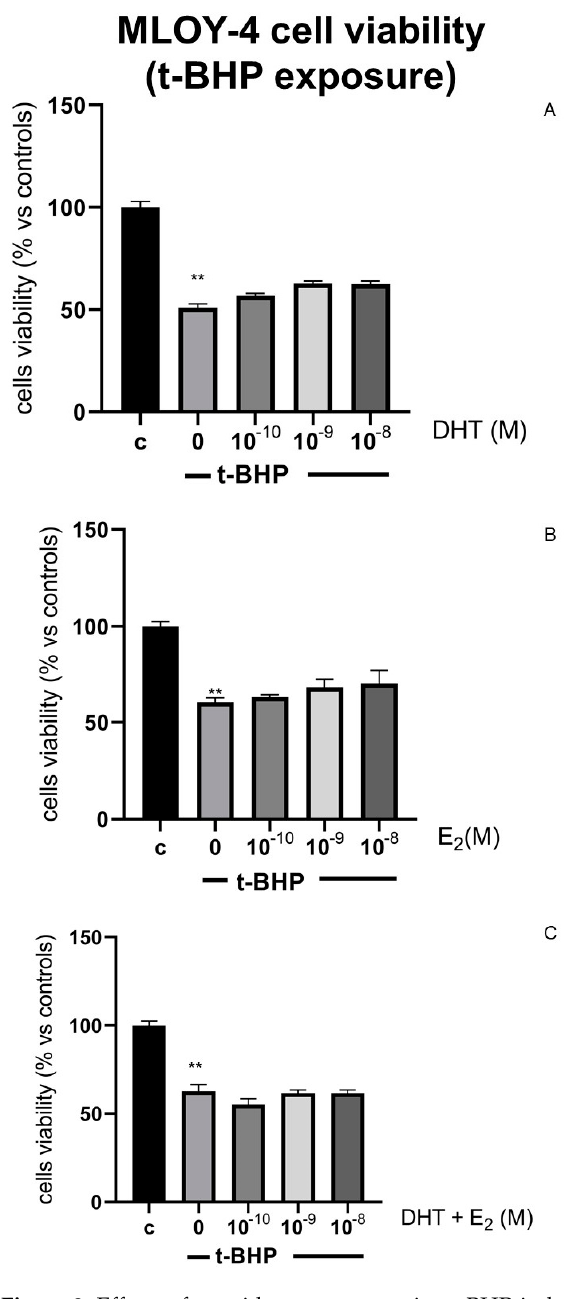
Figure 3. Effects of steroids on counteracting t-BHP-induced oxidative stress in osteocyte-like cells, MLOY-4. Effects of steroids on t-BHP-induced cytotoxicity in osteocyte-like cells, MLOY-4. Cells were pre-treated with E2 or DHT (range between 10 − 10 M to 10 − 9 M), 24 h before being treated with t-BHP (125 µ M for 3 h). Cell viability was measured by MTT assay 2 h after treatment. ( A ) shows the effects of DHT on t-BHP-induced cytotoxicity in MLOY-4 cells; ( B ) shows the effects of E2 on t-BHP-induced cytotoxicity in MLOY-4 cells; ( C ) shows the effects of a co-treatment of E2 + DHT on t-BHP-induced cytotoxicity in MLOY-4 cells. Data are represented as the mean ± SEM of six replicates within a single experiment. Column C represents the control (w/o steroids treatment and w/o t-BHP exposure); column 0 represents the t-BHP group w/o steroids. The columns 10 − 10 , 10 − 9 , 10 − 8 represent the columns with increasing doses of steroids and exposed to t-BHP. Differences between groups were evaluated by one-way ANOVA, followed by Bonferroni post-hoc test. The experiment was repeated three times. ** p < 0.05 vs. t-BHP.